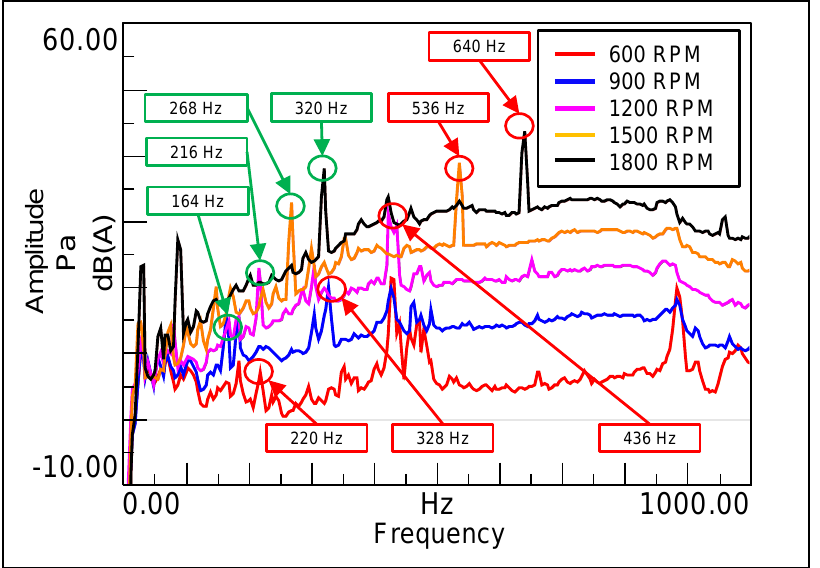
Figure 10. Zoomed-in acoustic auto-power spectrum from microphone aligned in motor’s radial direction.